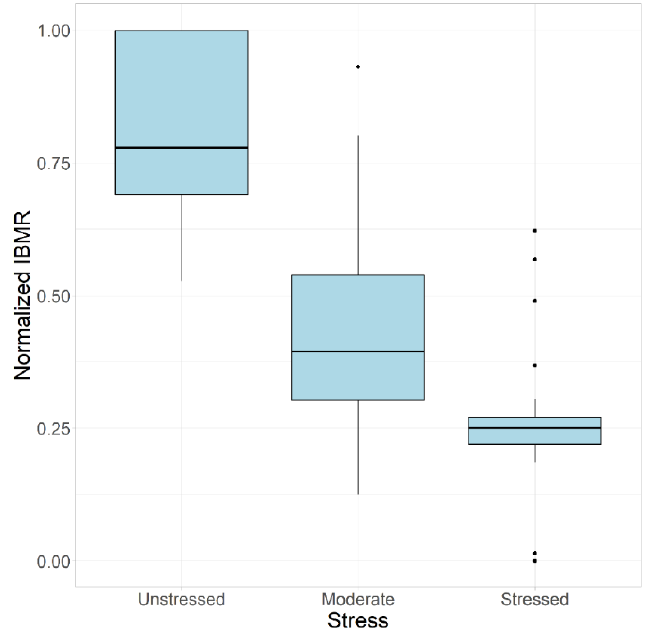
Figure 3. Boxplots of the normalized IBMR GR index among the unstressed, moderately stressed and stressed river reaches.